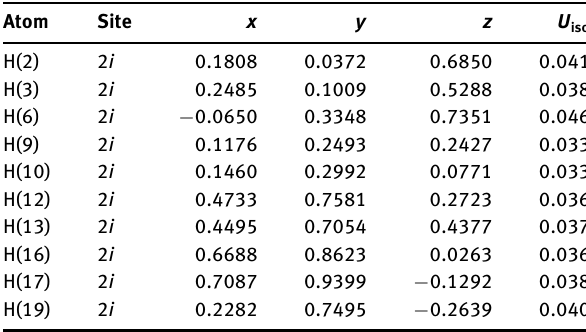
Table 2: Fractional atomic coordinates and isotropic or